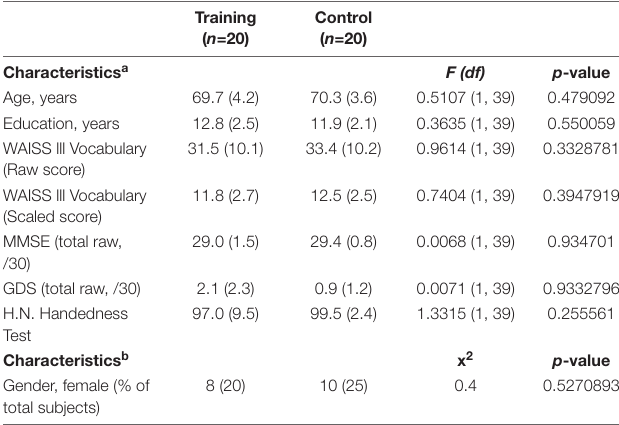
TABLE 1 | Baseline scores for the clinical and demographic characteristics of the control and cognitive training